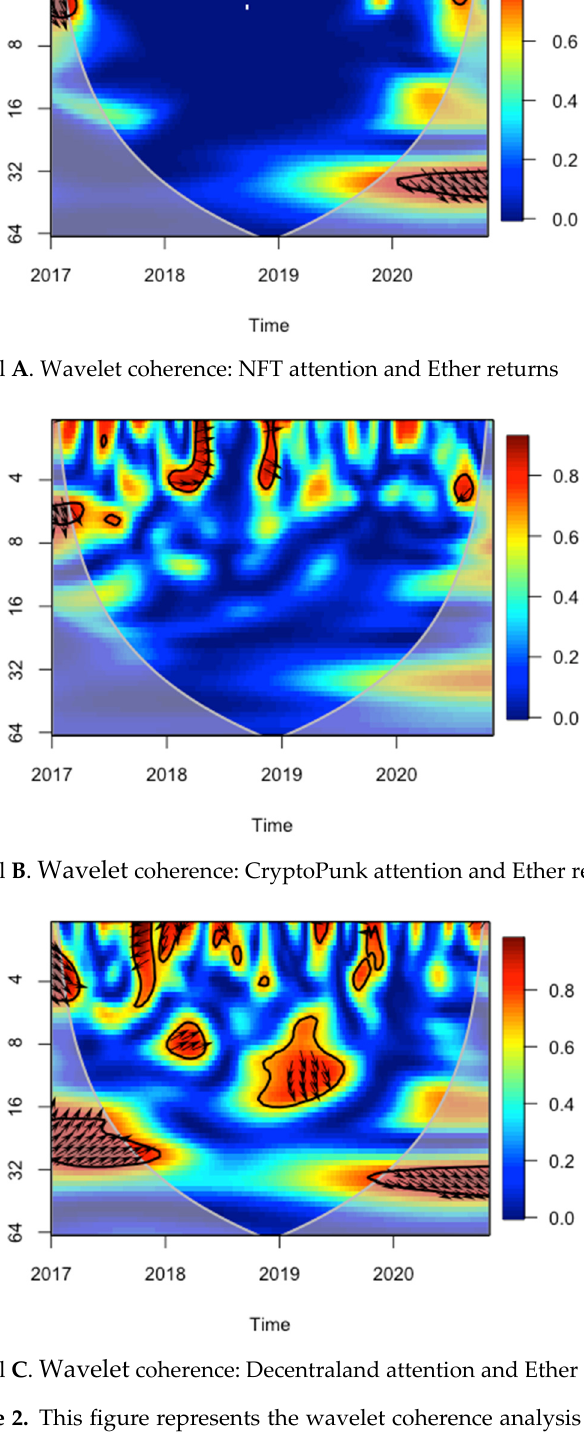
Figure 2. This figure represents the wavelet coherence analysis for Ether returns and NFT levels of attention (Panel A ), Ether returns and CryptoPunk attention (Panel B ), and Ether returns and Decentraland attention (Panel C ). Correlation is shown by the colour—hotter colours (cool blue to hot red) indicate higher absolute correlations. For the arrows, → shows positive correlation, ← shows negative correlation, (cid:37) and (cid:46) show Ether leads the NFT, and (cid:38) and (cid:45) show the NFT leads Ether. We use weekly Ether returns and Google search activity between 1 December 2017 and 30 July